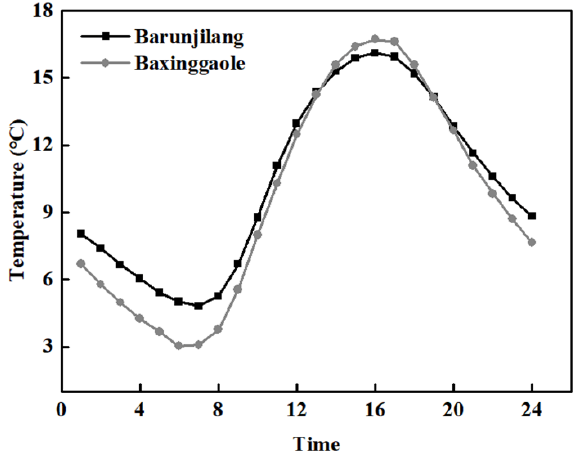
Figure 7. Daily temperature changes in the lake and non-lake areas.